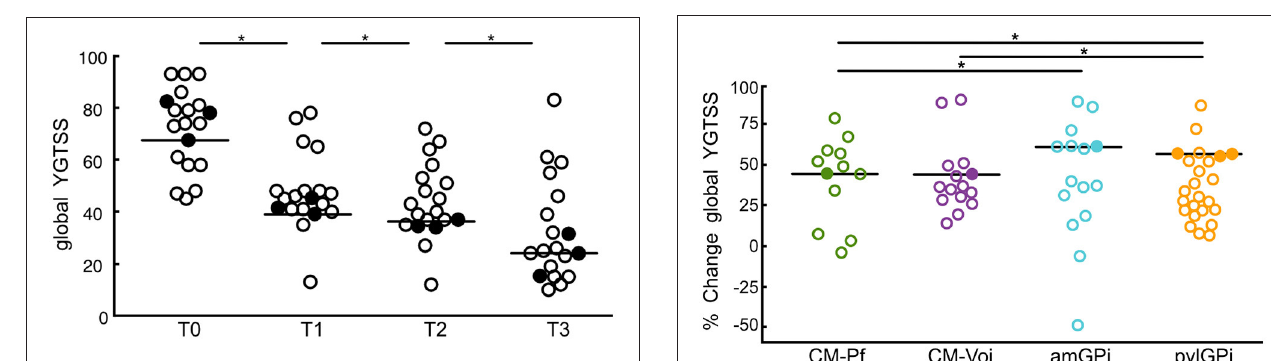
FIGURE 4 | Scatterplots of global YGTSS percentage change scores for the different targets at T2 (6–12 months after DBS surgery). Circles represent individual studies; color-filled circles represent more heavily weighted studies (more participants). Horizontal bars show the median values for each target. Significant differences between targets are indicated with asterisks ( p < 0.05).